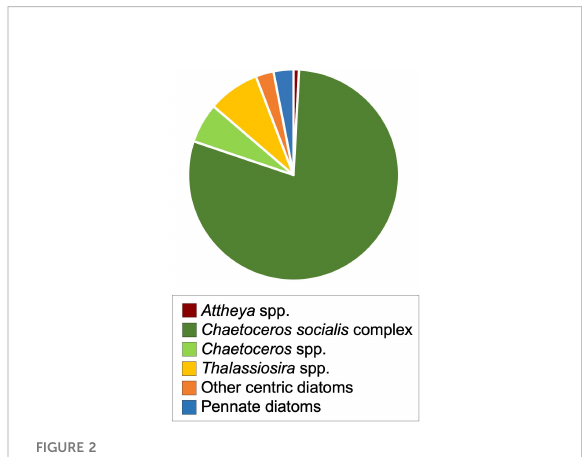
FIGURE 2 The composition of viable diatom cells at station 35 by the MPN method, which was assessed just before the incubation